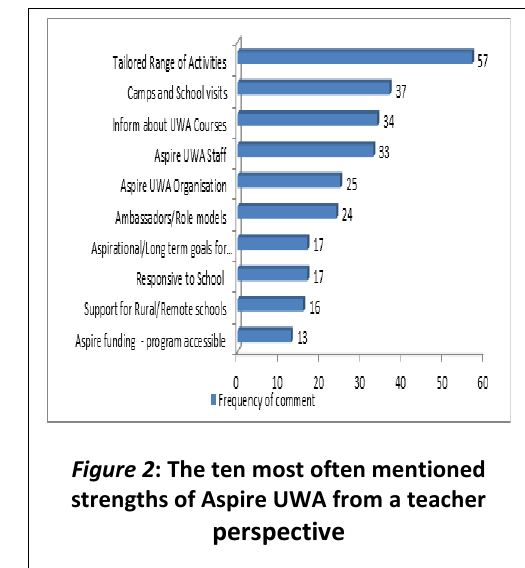
Figure 2 : The ten most often mentioned strengths of Aspire UWA from a teacher